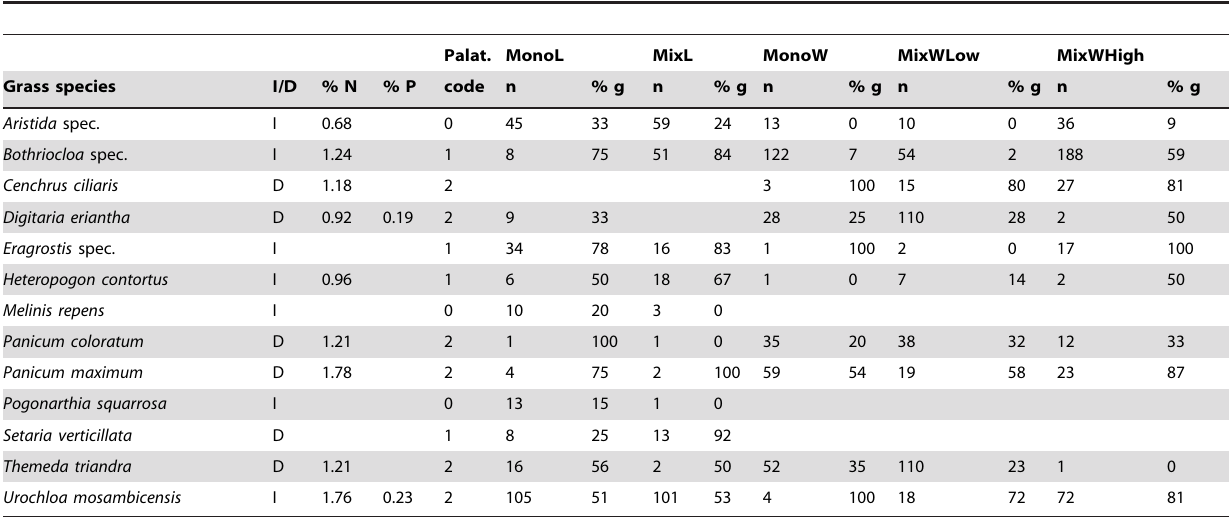
Table 3. Average grass leaf nitrogen (N), phosphorus (P), increaser (I) or decreaser (D) species and palatability (Palat.code: 0= not palatable, 1= moderately palatable, 2= highly palatable) with respect to veld condition [42].